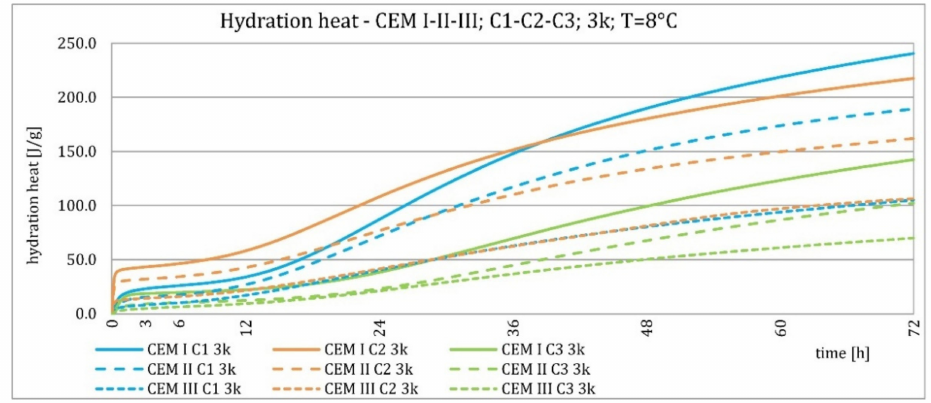
Figure 19. Hydration heat of C1-C2-C3 clinker based non-modified cements CEM I, CEM II/B-S, CEM III/A at 8 ◦